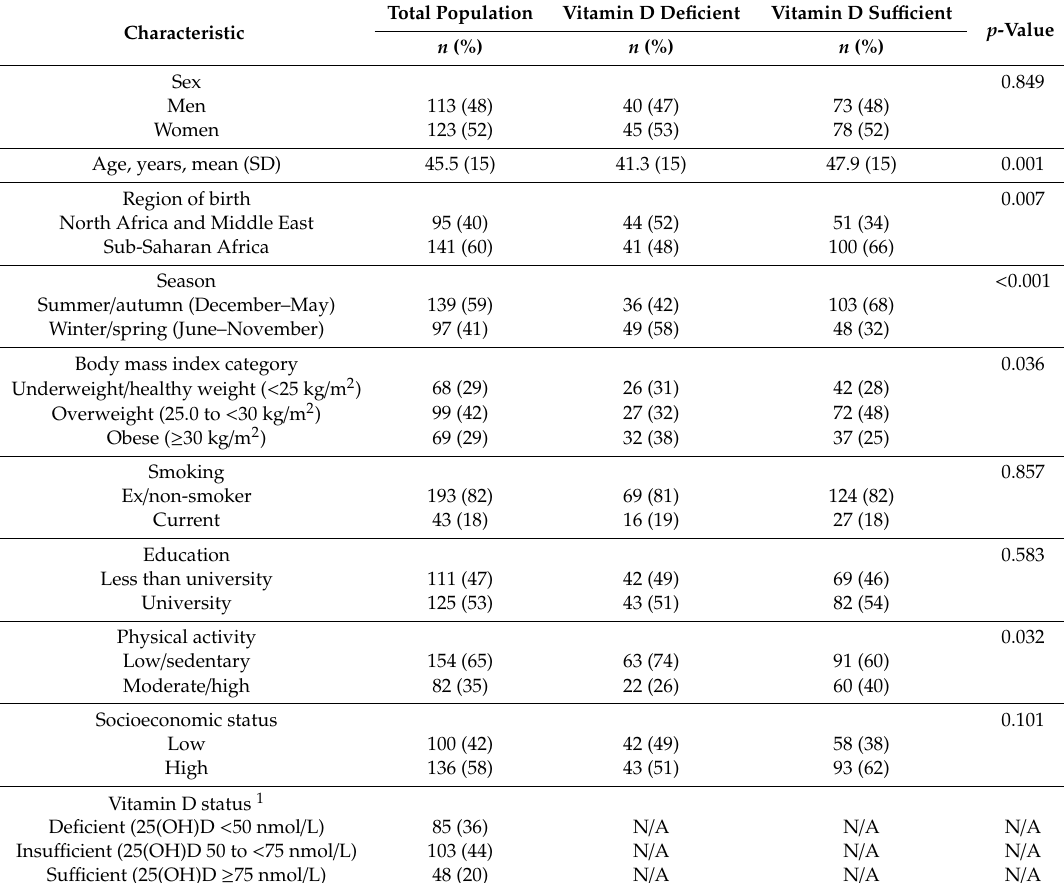
Table 1. Characteristics of adults aged ≥ 18 years who were born in Africa and were included in the current study, in the total population ( n = 236) and in those with vitamin D deficiency ( n = 85) and